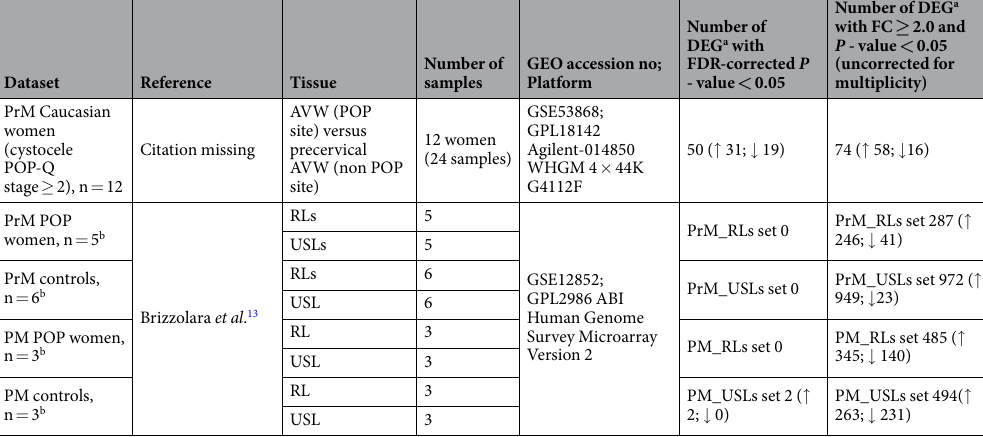
in the genes LIN28B 29 and AGT 30 were associated with POP and mitral valve prolapse (MVP) respectively. Nfil3-/- mice developed colitis with high prevalence of rectal prolapse 31 . High expression of Nlrp3 was found in Il10-/- mice with colitis combined with rectal prolapse 32 . The genes CTSK 33 , MMP19 and THBS4 34 were over-expressed